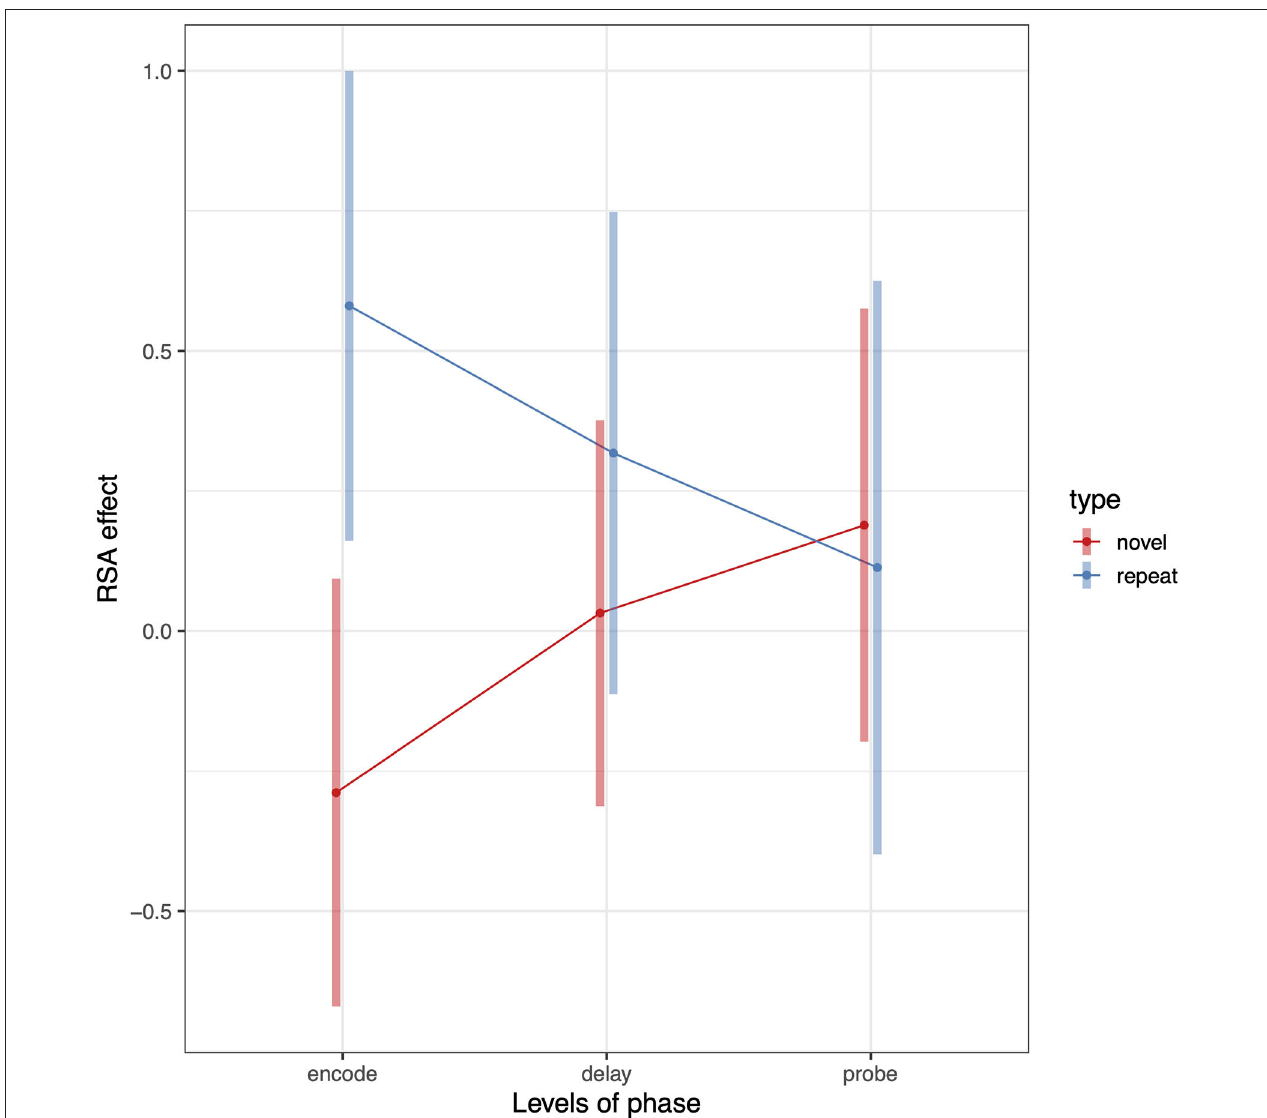
FIGURE 5 | Pattern of RSA effects in Spt/PSL for repeated sequence and novel sequence RSA analyses. Error bars are 95% confidence intervals.